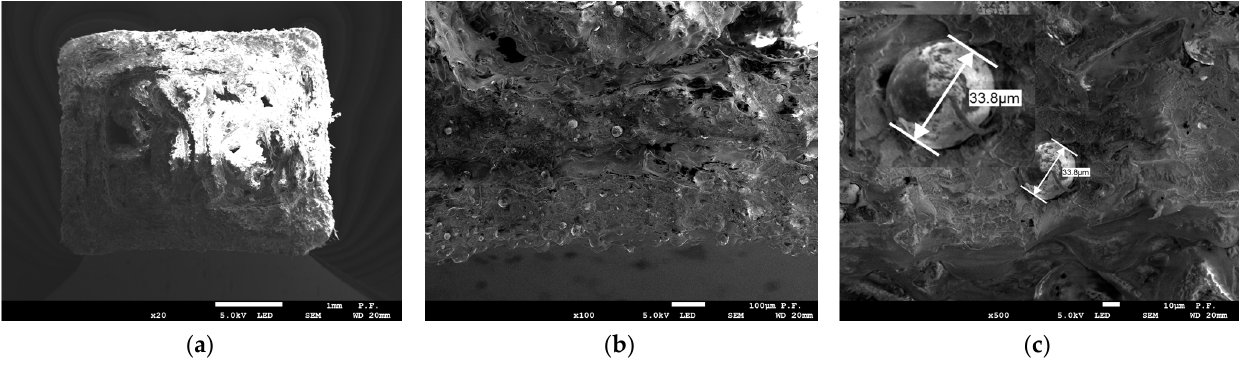
Figure 9. Cross-section of specimen 4.0 2Z composed of PLA + bronze after fracture observed with a scanning electron microscope. Observation direction—perpendicular to the cross-section; ( a ) magnification × 25; ( b ) magnification × 100; ( c ) magnification ×